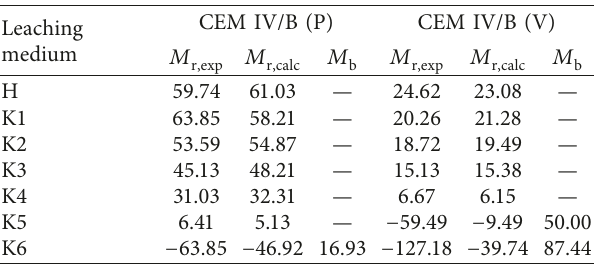
Table 8: Experimental and calculated M corresponding M b